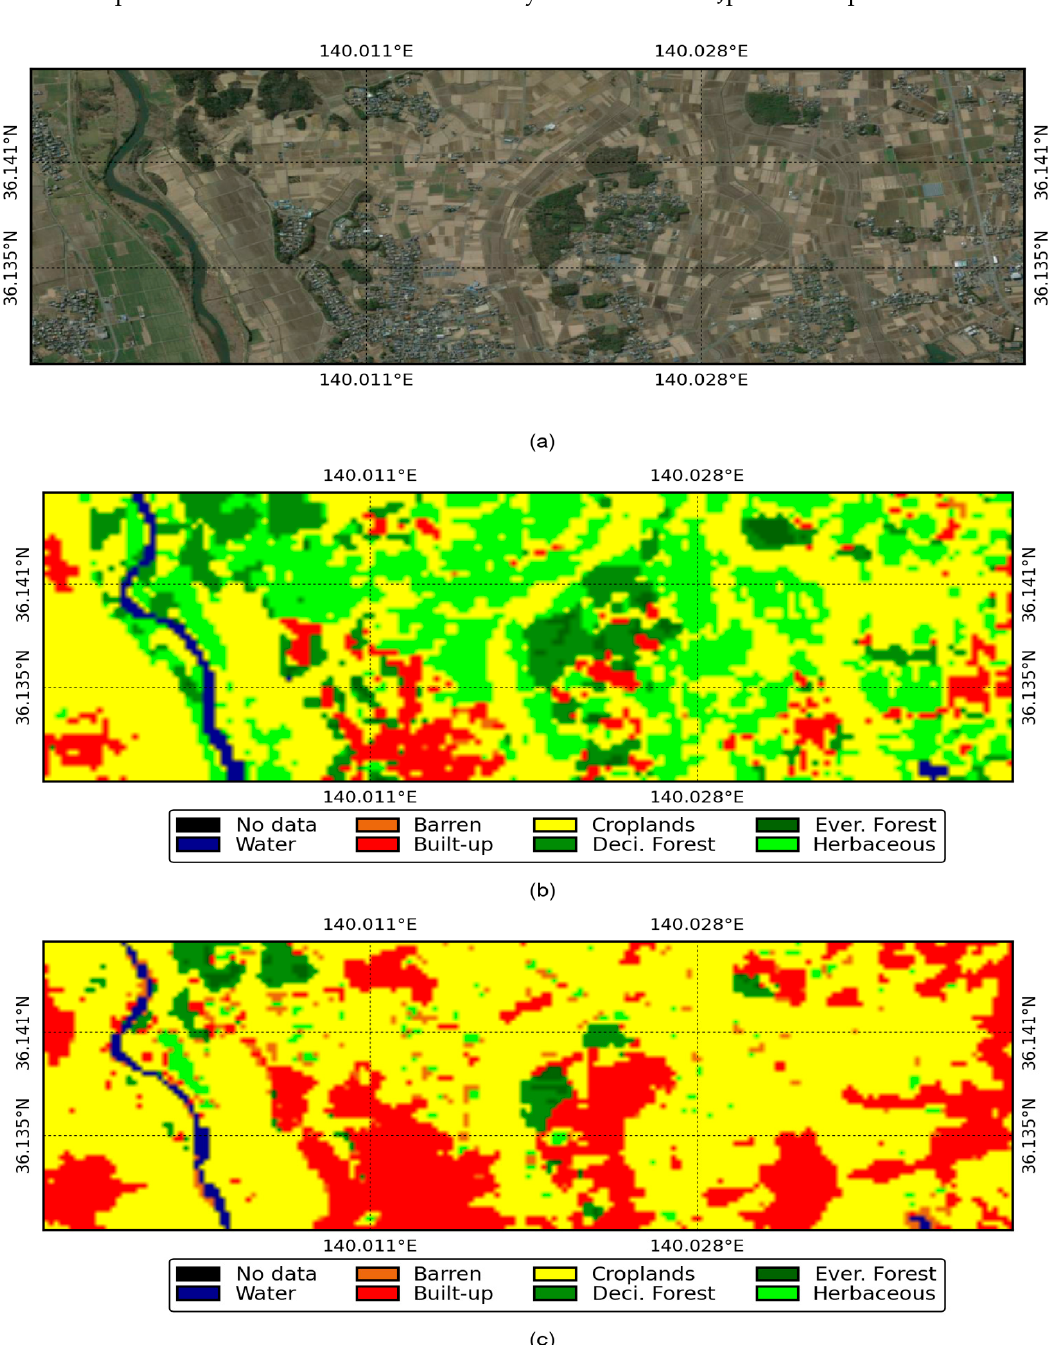
Figure 16. Performance of the JpLC-30 map over the JHR LULC map: ( a ) Google Earth™ image; ( b ) JHR LULC map; ( c ) JpLC-30 map.